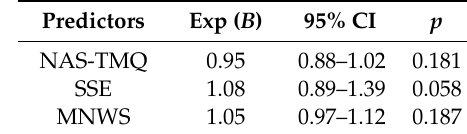
Table 2. Binary logistic regression analysis of composite measures predicting smoking relapse at the 3 month follow-up.